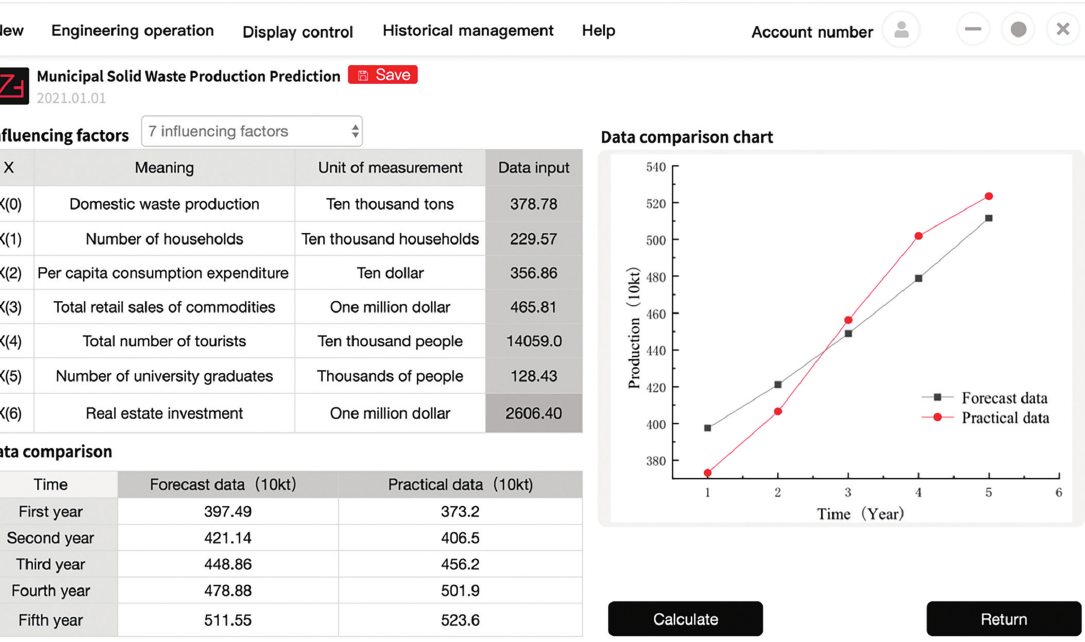
Figure 4: Municipal solid waste (MSW) production prediction.